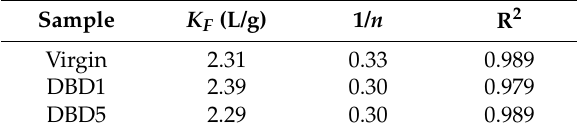
Table 1. Freundlich constants for adsorption of indigo carmine onto